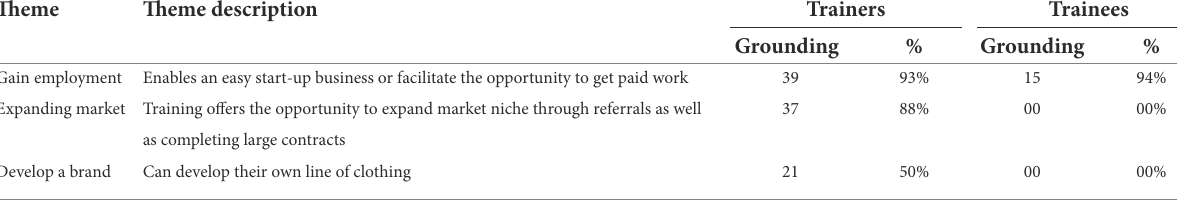
TABLE 4 Perceived opportunities of informal training and sustainable livelihoods of unemployed youths.